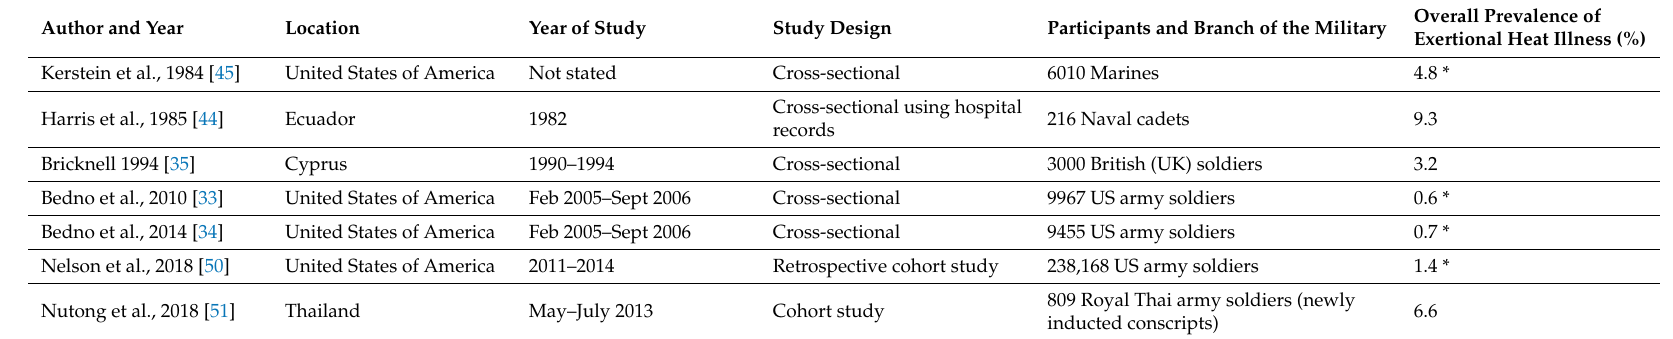
Table 2. Prevalence of all exertional heat illness in the armed